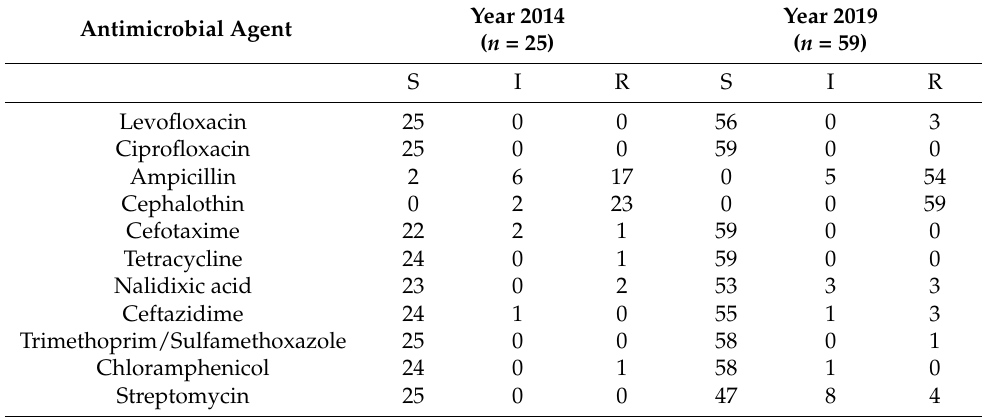
Table 9. Antimicrobial susceptibility/resistance of Y. enterocolitica 4/O:3 isolates from medium- sized